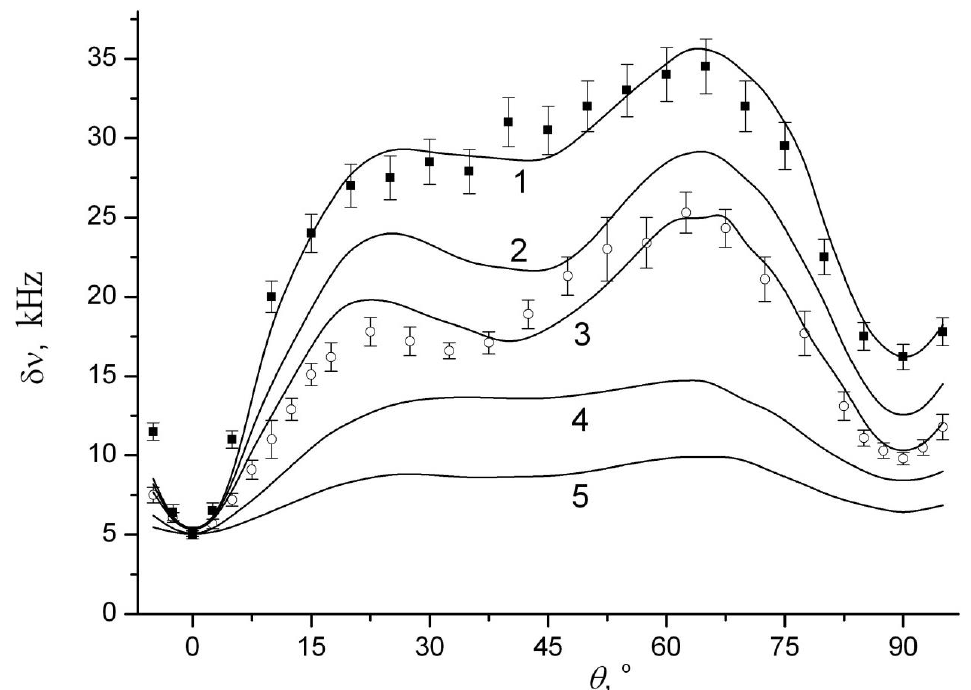
Figure 10. The results of modeling the angular dependence of the 93 Nb NMR linewidth for: (1) M = 48.4 mol%; (2) M = 49.2 mol%; (3) M = 49.6 mol%; (4) M = 49.8 mol%; and (5) M = 49.9 mol%.